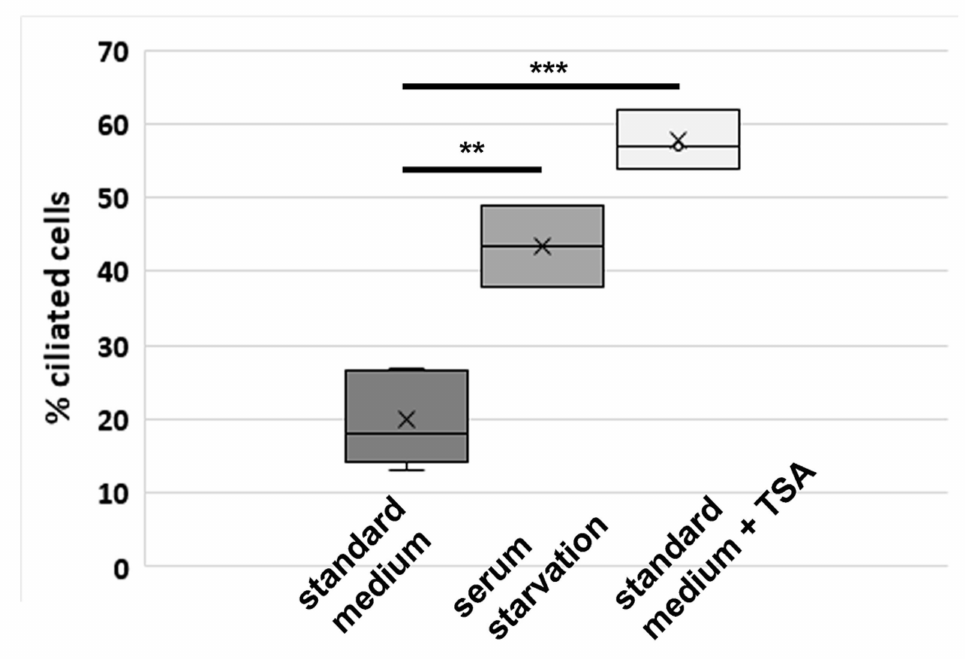
Figure 4. Increase of ciliation by either serum starvation or TSA-mediated inhibition of HDAC6 in the NIH3T3 sub-cell line “DSMZ”, which was freshly obtained from DSMZ. Cells were either cultivated in standard medium for 24 h (without or with the addition of TSA) or in serum starvation medium for another 48 h before processing for immune decoration for acetylated tubulin. Standard medium: five biological replicas, n = 1555; serum starvation: duplicate experiment, n = 1035; standard medium + TSA: triplicate experiment, n = 1362). Statistically significant differences of ciliation according to Student’s t -test: p ** standard medium versus serum starvation, p *** standard medium without TSA versus with